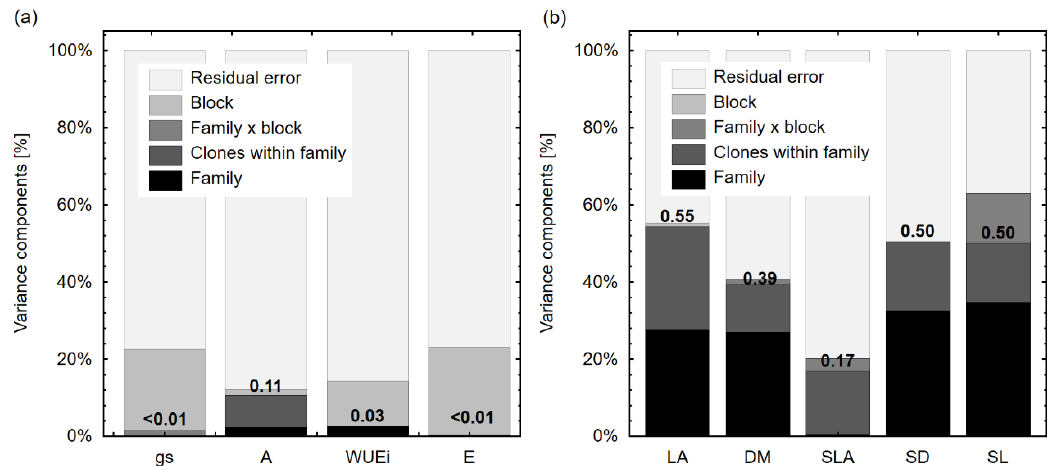
Figure 4. Variance component analysis for random e ff ects in the linear mixed model. Variance components were estimated using the restricted maximum likelihood (REML) method for ( a ) physiological traits (gs, A, WUEi, E) and ( b ) morphological traits (LA, DM, SLA, DS, SL) of 10-year-old hybrid poplars. Broad sense heritabilities are shown as numerical values above the bars for the combined e ff ect of family and clone within family (genetic e ff ect). The meaning of the trait abbreviations as in Table 2 footnote.